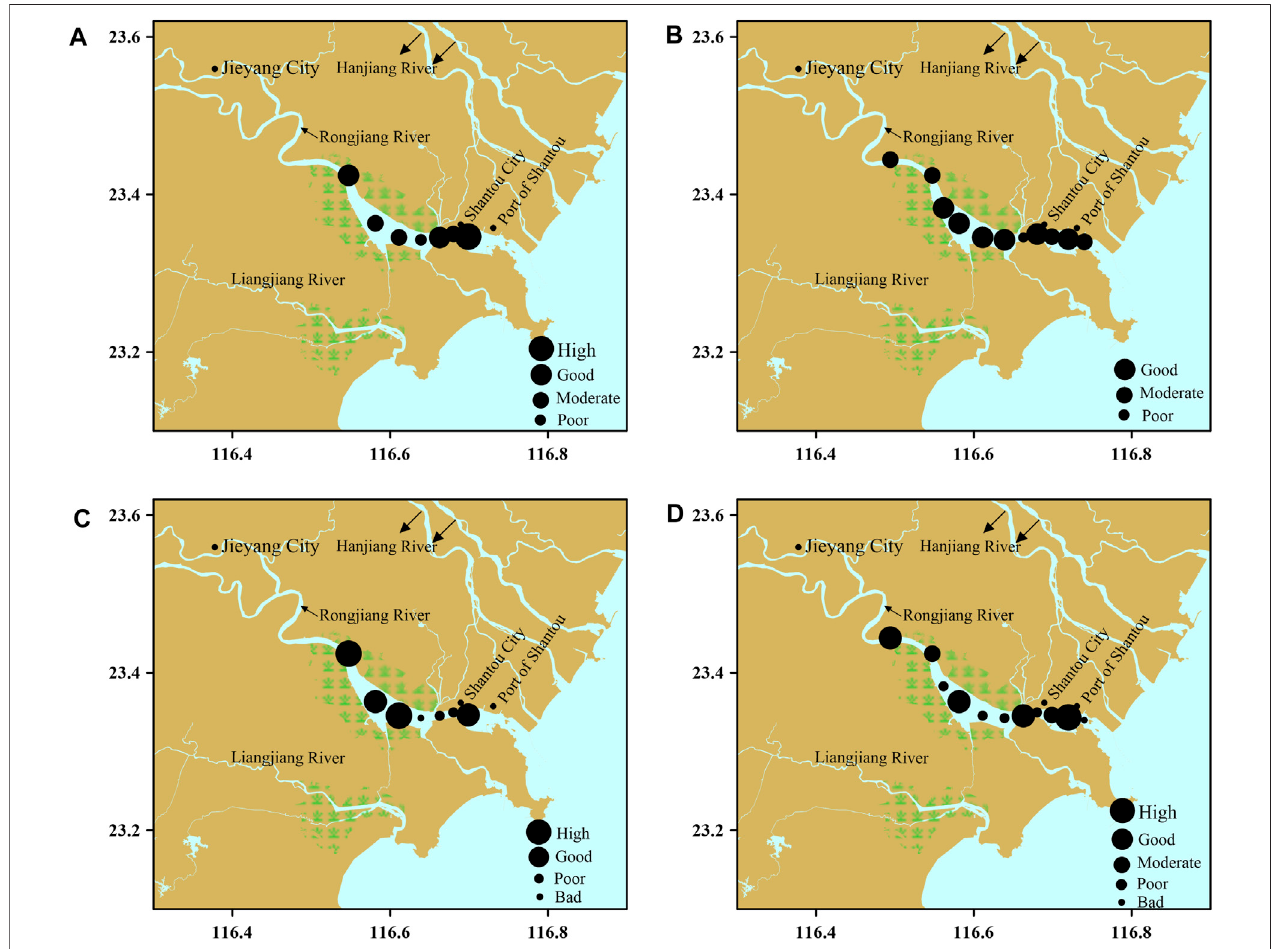
FIGURE 2 | Temporal and spatial variation in AMBI and M-AMBI indices, Rongjiang River. AMBI: (A) summer, (B) winter; M-AMBI: (C) summer, (D) winter.